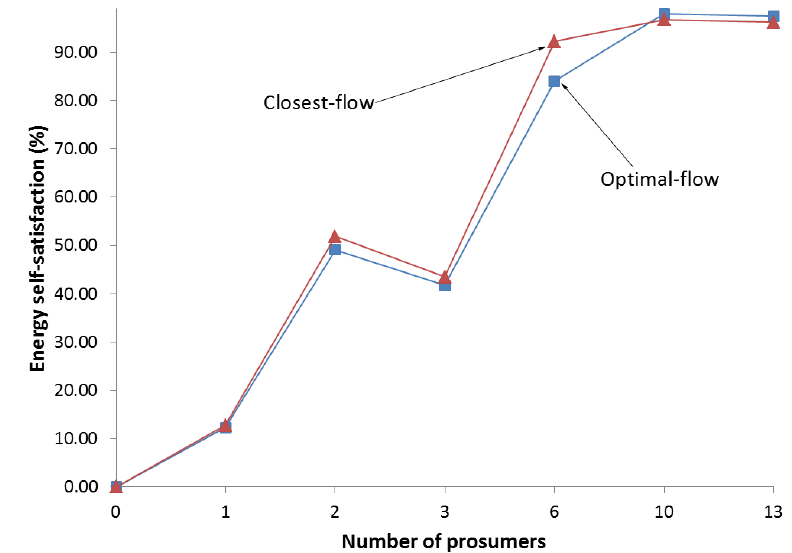
Figure 4. Proportion of energy self-satisfaction.